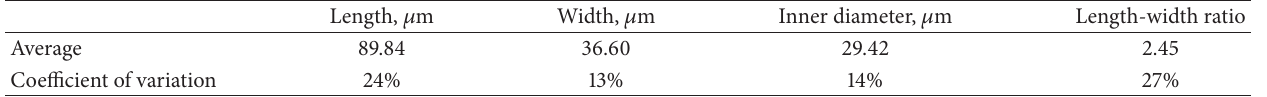
Table 1: The dimension of bamboo fibre.